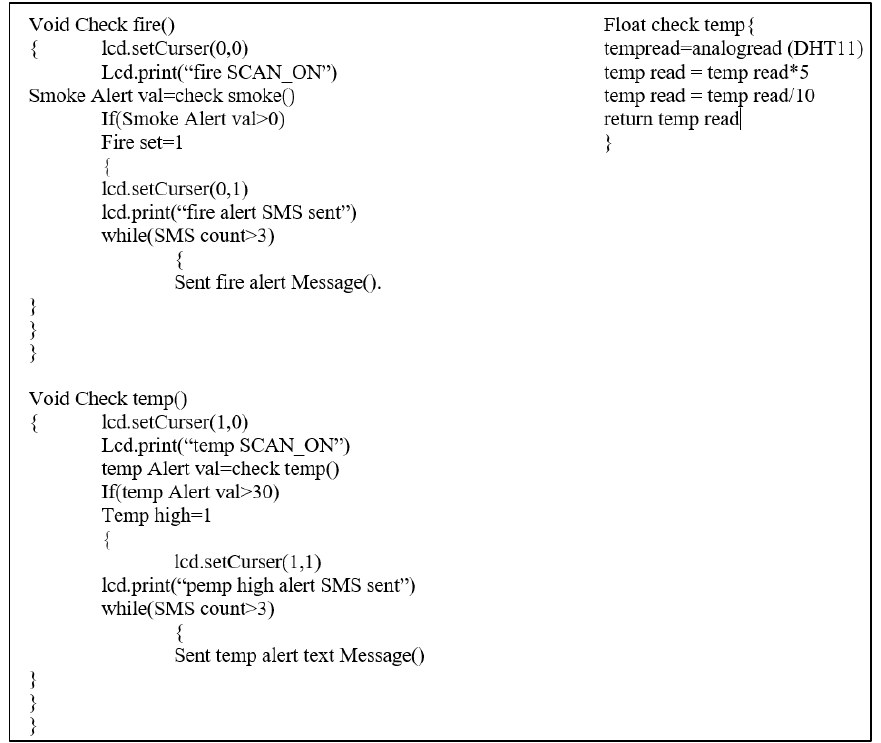
Figure 9: The program code for detect smoke and measuring temperature.